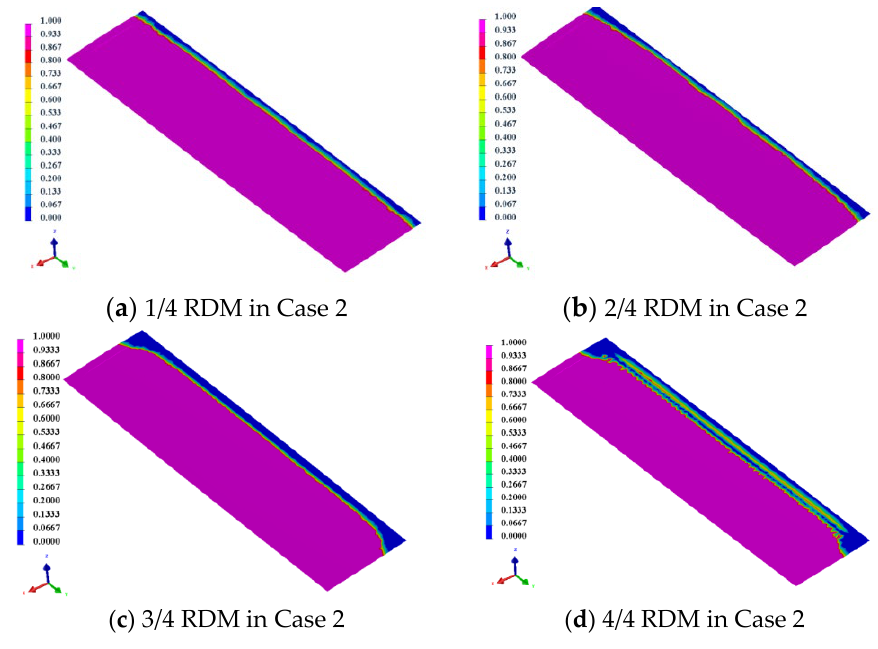
Figure 8. Resin flow front in Case 2.